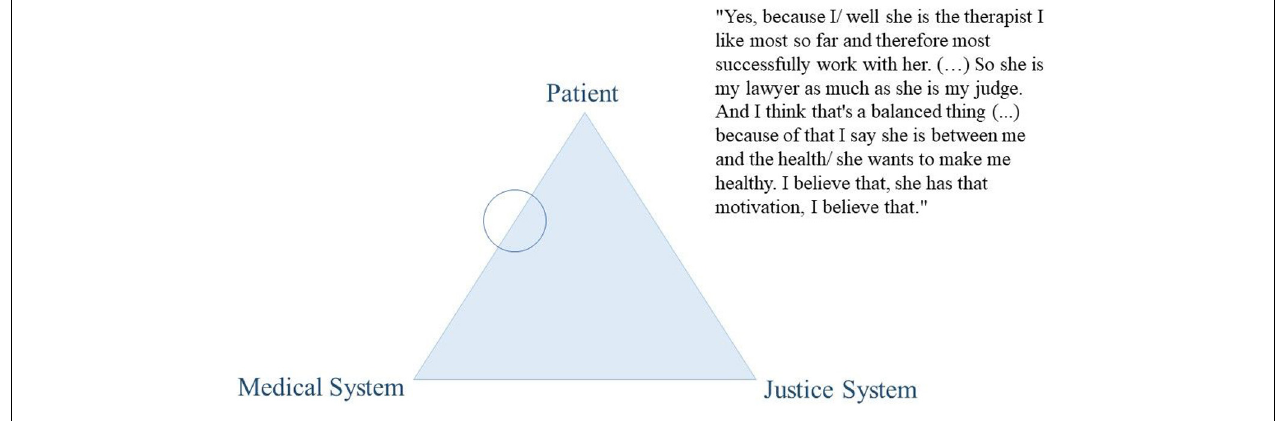
FIGURE 5 | Citation of participant